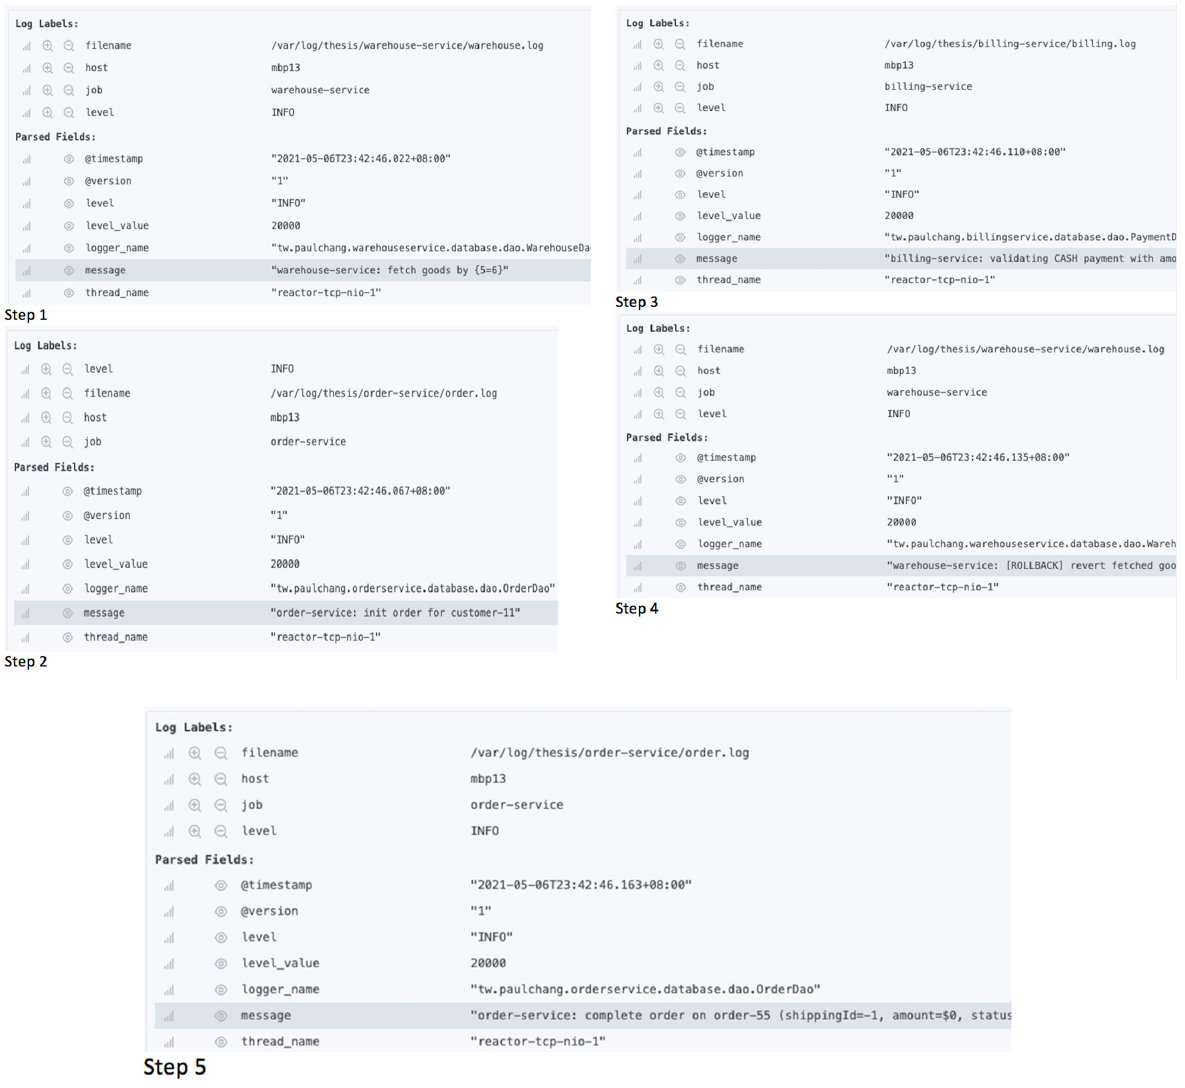
Figure 11. The Steps performed by version 1 (deploying standard saga pattern) when an exception has